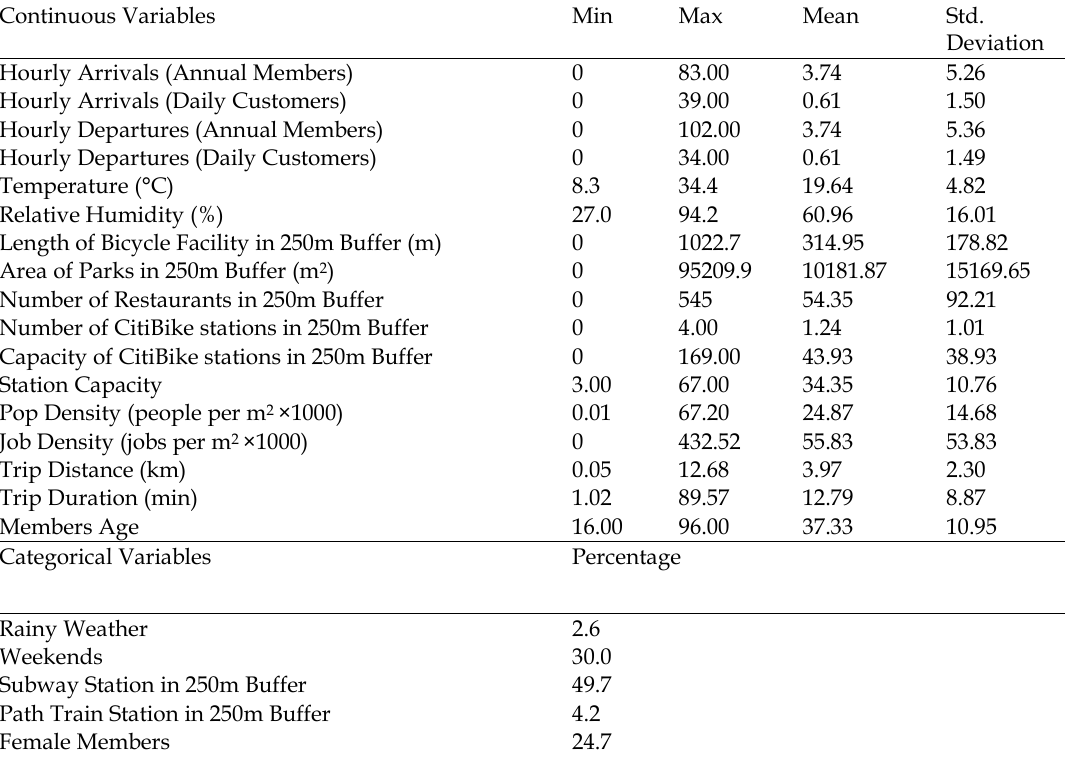
Table 1. Descriptive Summary of CitiBike Sample